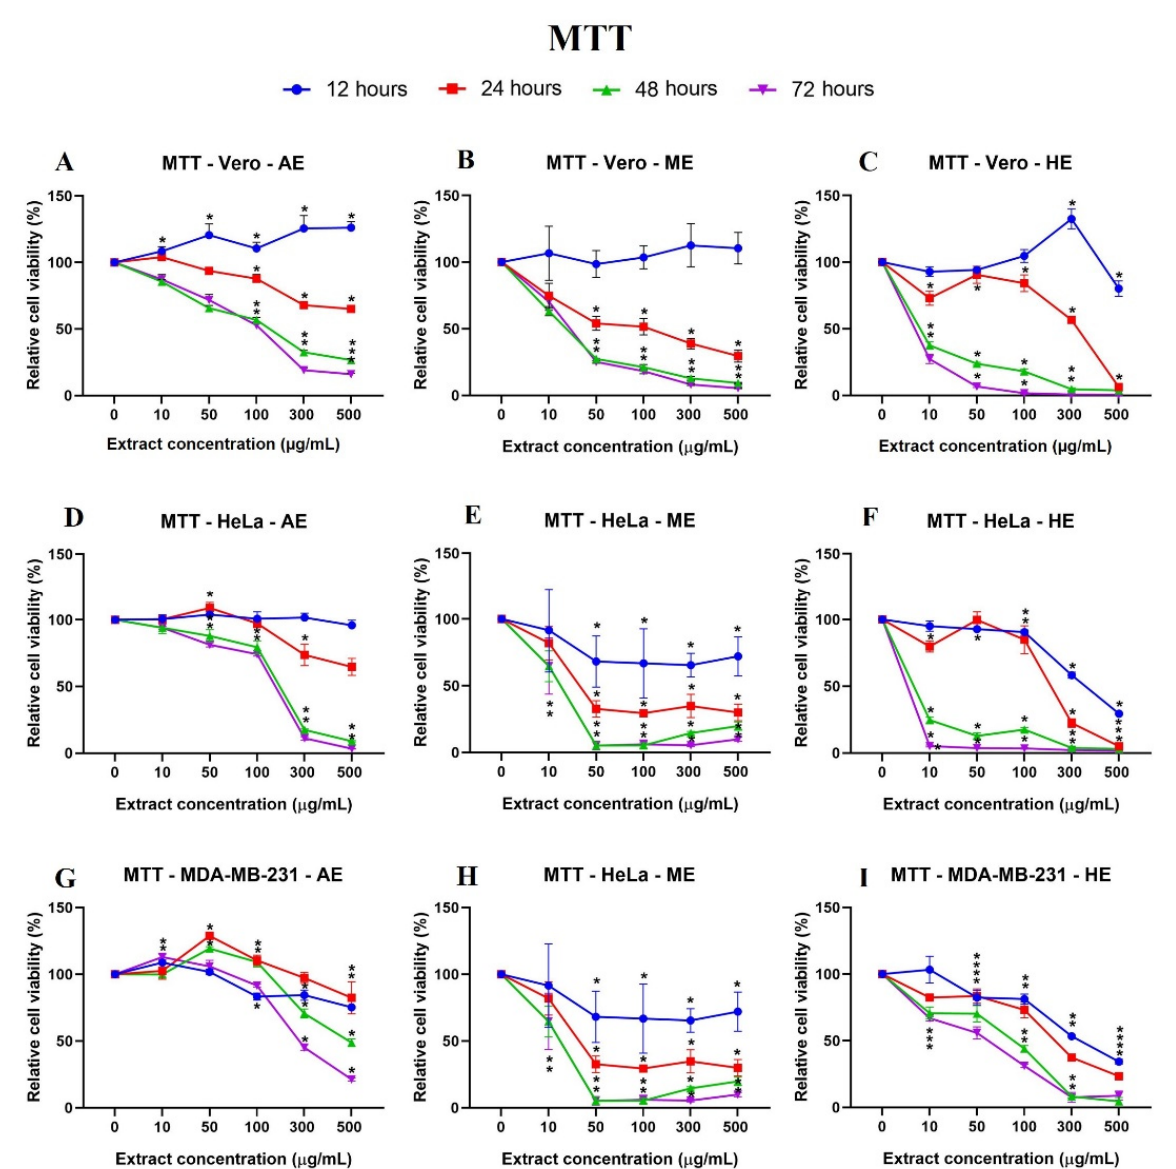
Figure 8. Cell behavior against different concentrations of A. monostachya extracts by MTT assay. Comparisons of the effects of AE, ME, and HE on the cell lines: Vero ( A – C ), HeLa ( D – F ), and MDA-MB-231 ( G – I ) after exposure to the extracts at 12 (blue line), 24 (red line), 48 (green line), and 72 h (purple line) are presented. The graphs show the % area as a function of the concentration of the extracts. It can be seen that HE has a greater cytotoxic effect on the tumor cell lines at 24 h and later. The HeLa cells showed greater sensitivity to the extracts. * p < 0.05, Tukey’s multiple comparison test vs. vehicle-treated cells.